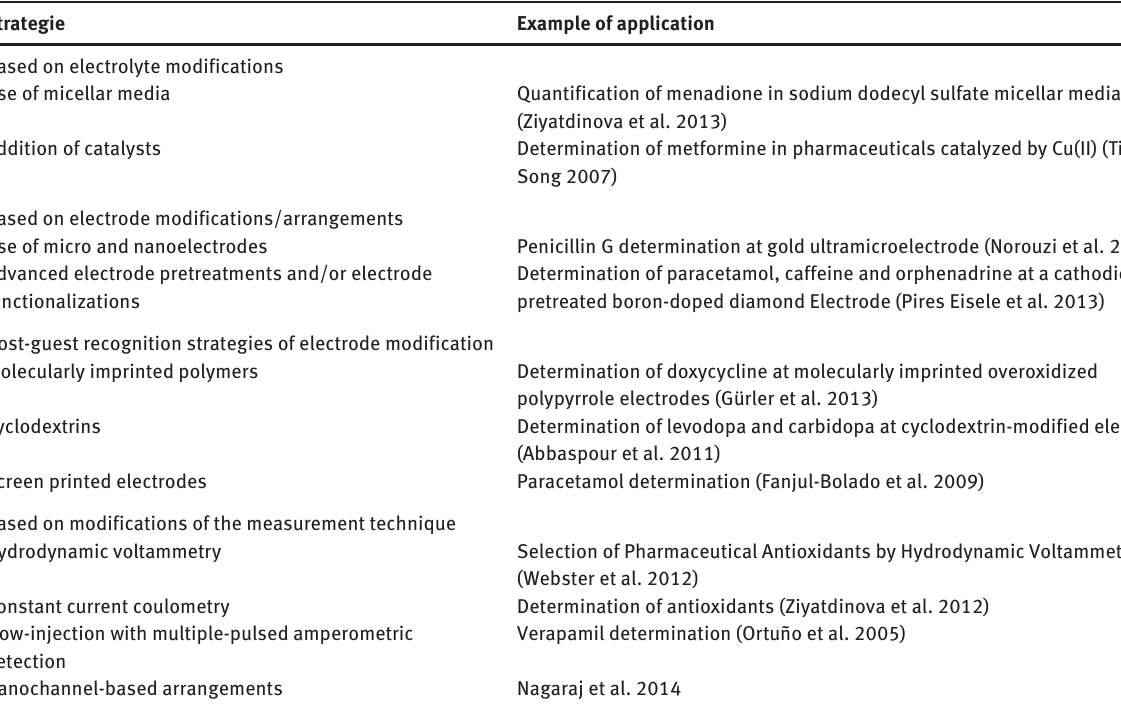
Table 2 Several electrochemical strategies complementing the direct voltammetric/amperometric measurements at macroelectrodes in analyte solutions reported in recent literature for determining pharmaceuticals.